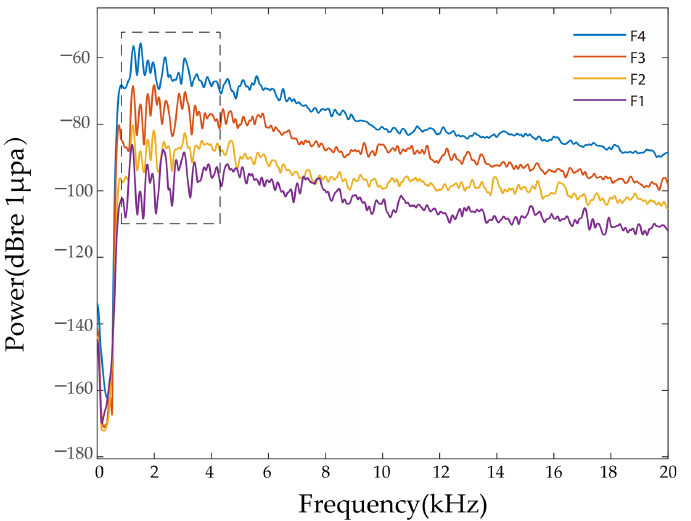
Figure 3. Comparison of feeding acoustic power spectrum of largemouth bass under different breeding densities.